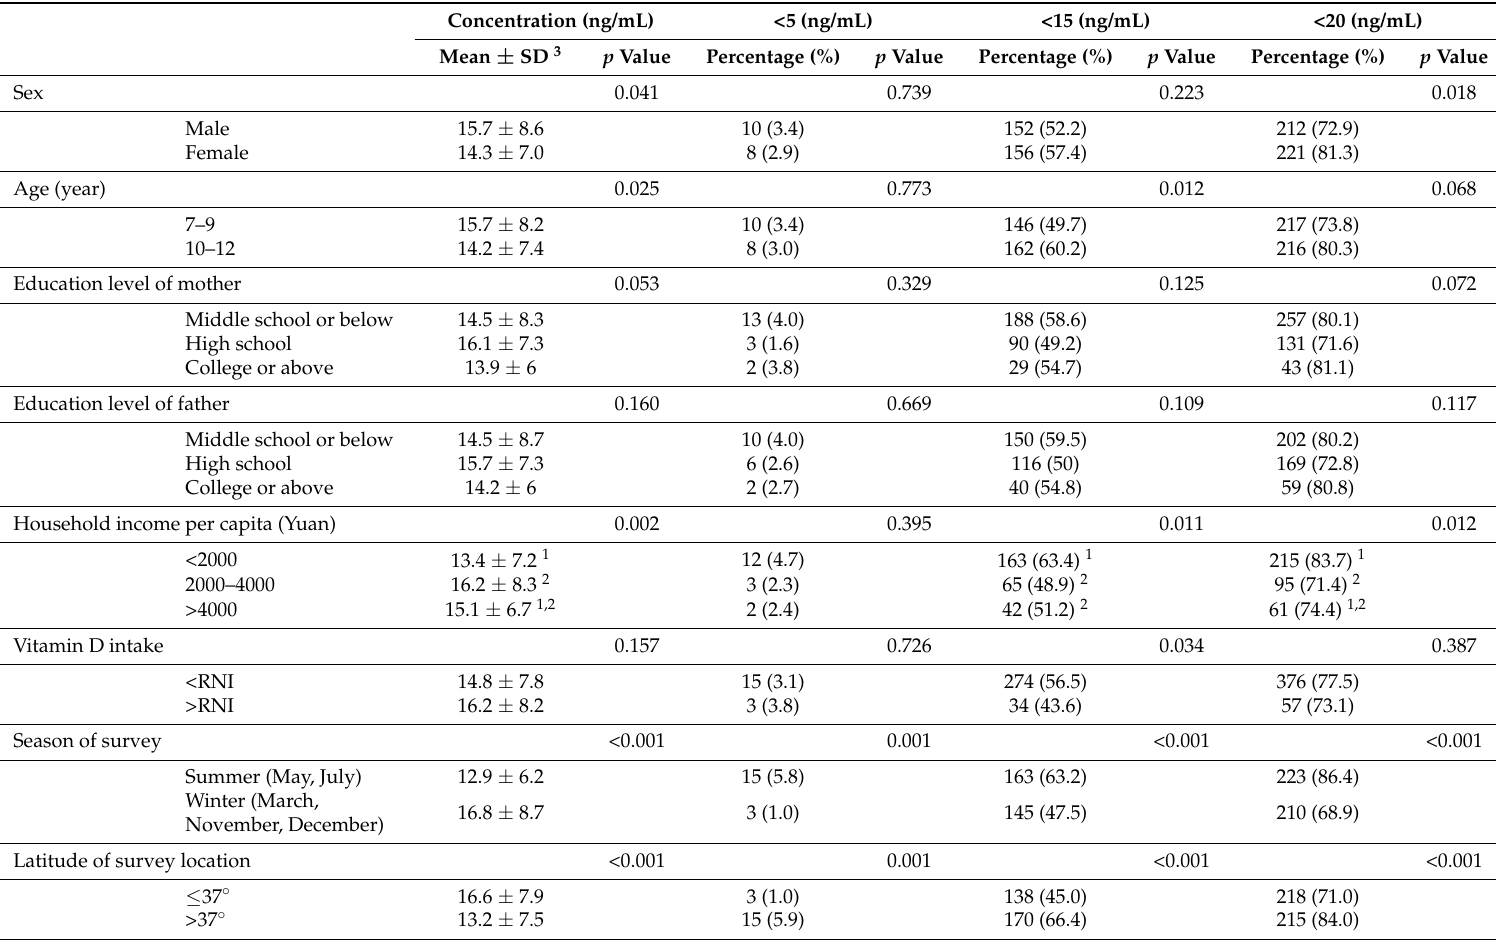
Table 3. Serum vitamin D status of school-age children by relevant